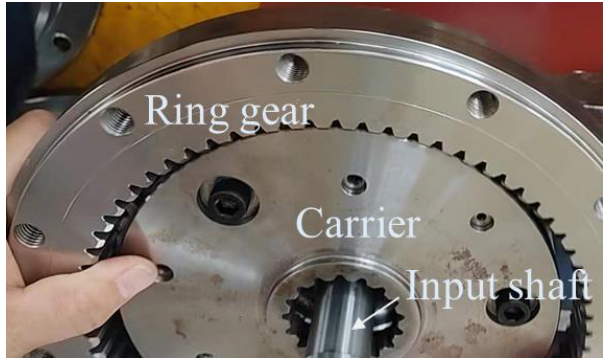
Figure 10. The photo of the planetary gear set assembly in the gearbox.